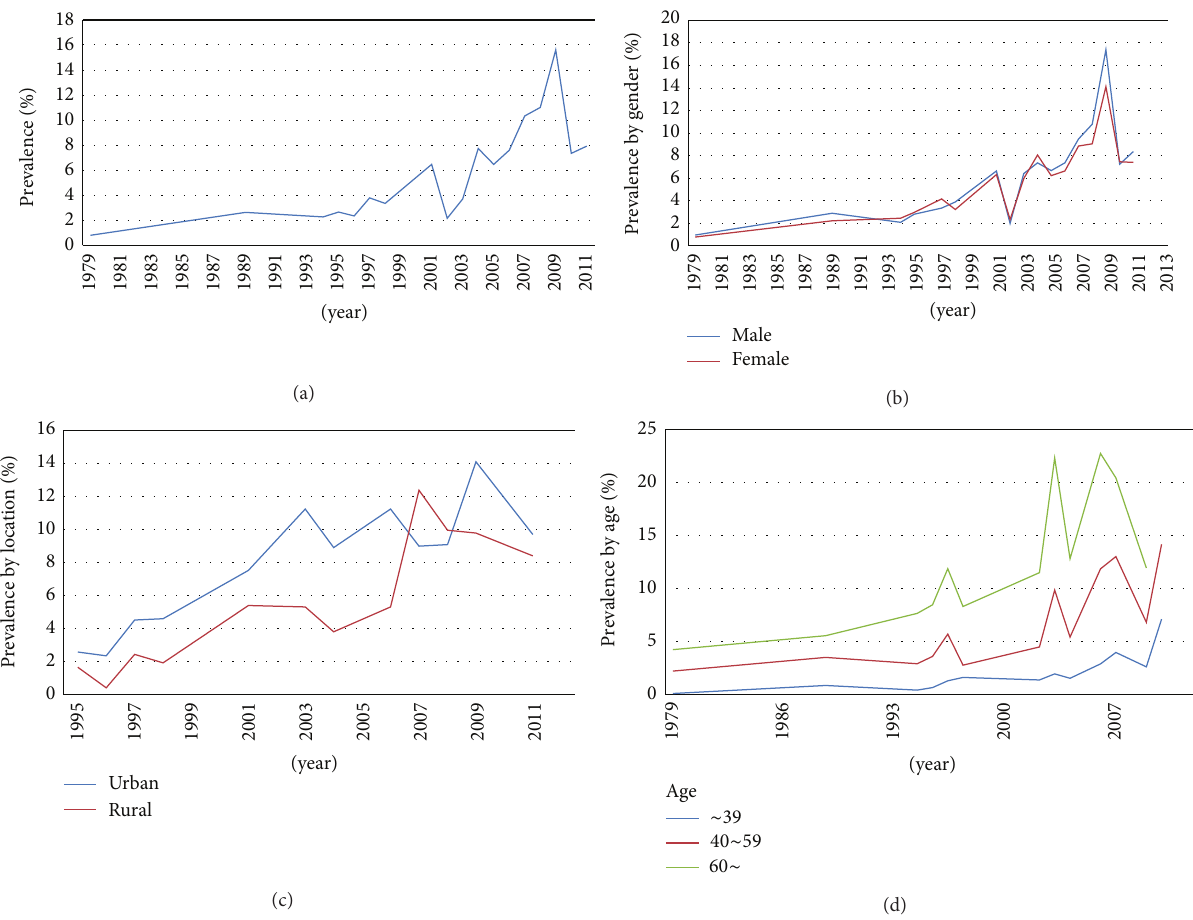
Figure 1: Trends in prevalence of diabetes and subgroup analysis by gender, location, and age.